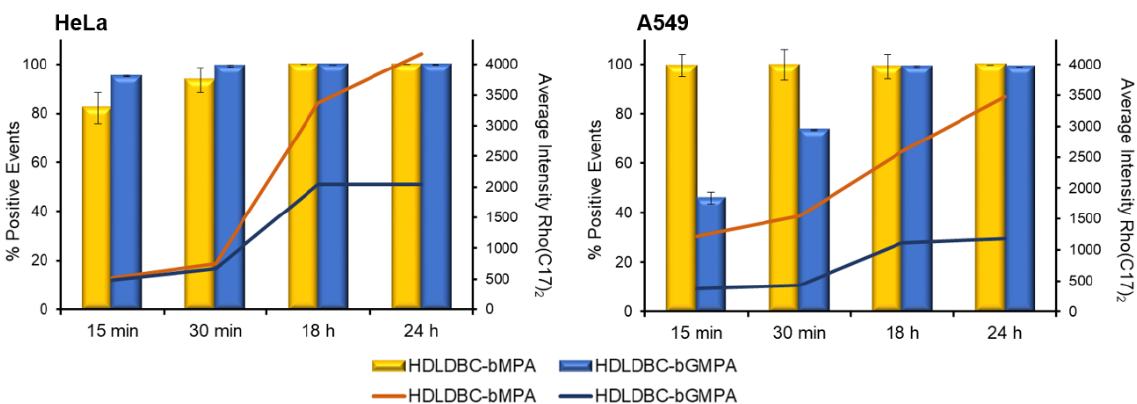
Figure 3. Internalization curves of HDLDBCs (Rho(C17) 2 ) in HeLa and A549 cells. Flow cytometry analysis after incubation of cells with rhodamine-labeled HDLDBC-bMPA or HDLDBC-bGMPA at different time points. Yellow and blue bars represent the percentage of rhodamine-positive events relative to the total number of events recorded. Orange and blue lines represent the average rhodamine intensity of each population at different time-points.